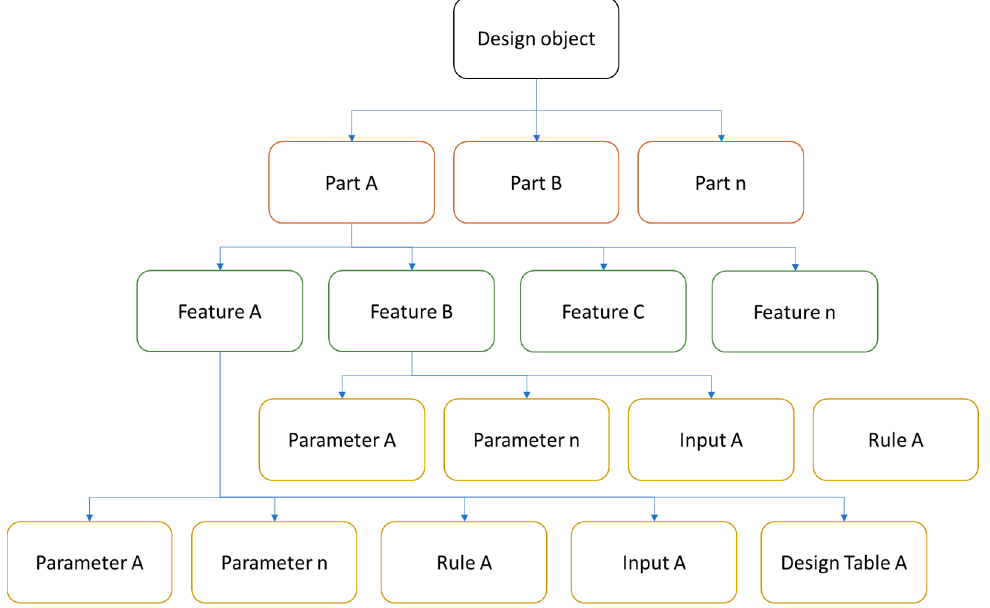
Figure 7. The idea of the decomposition process.